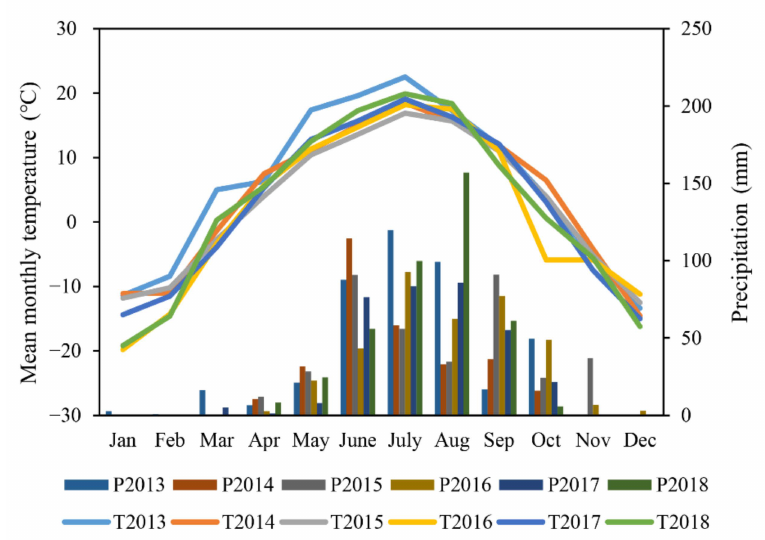
Figure 1. Monthly means of precipitation (mm) and temperature ( ◦ C) from 2013 to 2018 in the field located in Yuershan, Hebei Province, China. Bars indicate precipitation (P2013~P2018), and lines indicate temperature